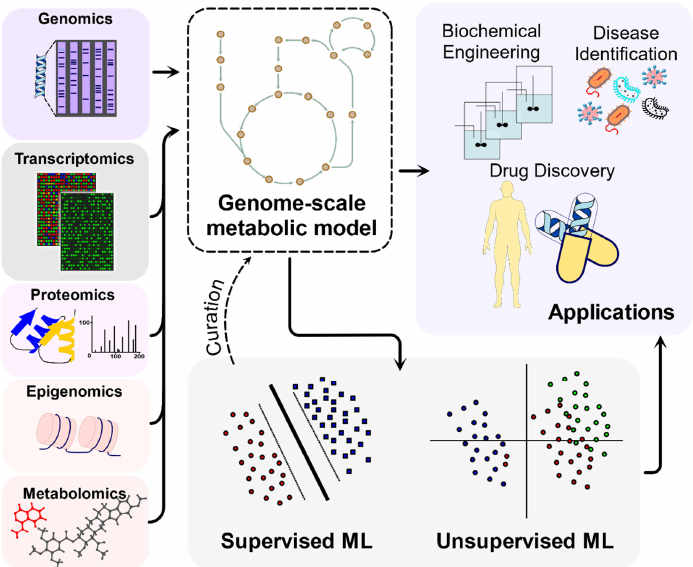
Figure 2. Big Data types commonly used in metabolic modeling . The left panel represents different omics data applied to the GEM providing different layers of biological knowledgebase. Machine learning can be applied to increase the predictive capability of the reconstructed GEMs. Different applications of GEMs are shown in the top right panel and discussed in detail in the